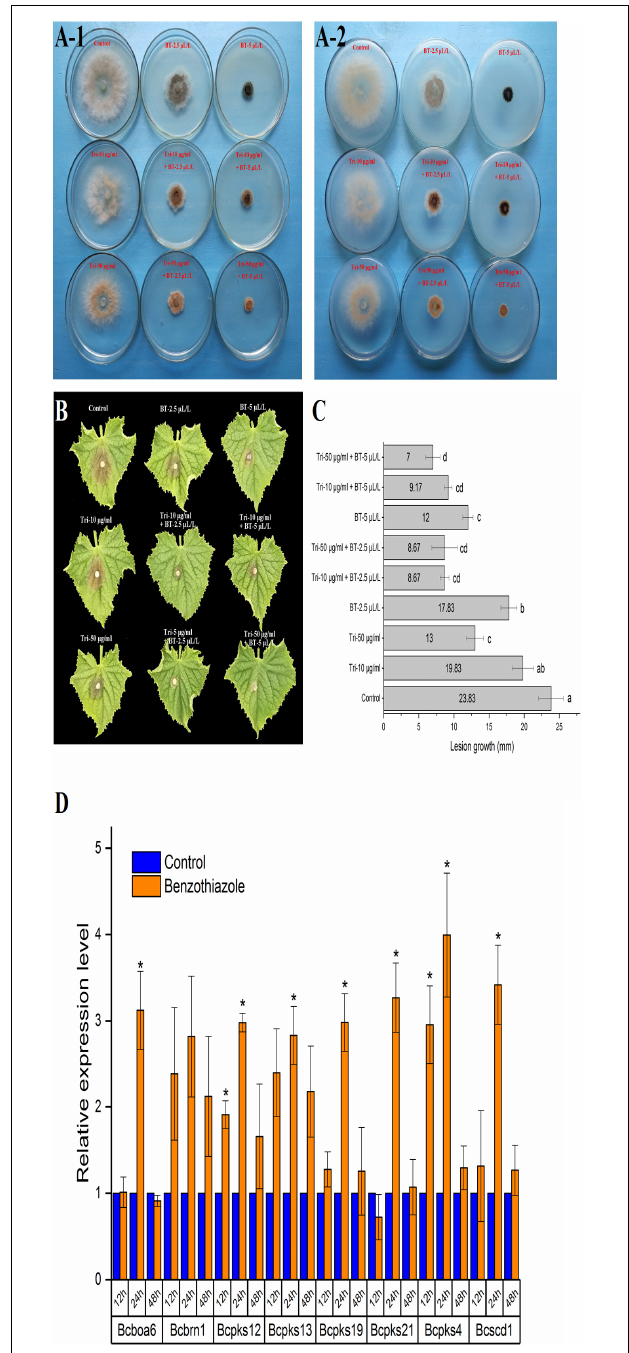
FIGURE 6 | Analysis of the effect of benzothiazole on melanin production in Botrytis cinerea . (A) Melanin biosynthesis of Botrytis cinerea with or without exposure to benzothiazole and tricyclazole (a fungal dihydroxynaphthalene melanin biosynthesis inhibitor) observed from the front (A-1) and back (A-2) of the petri dishes. (B) Virulence variation resulting from different extents of melanin biosynthesis inhibition. (C) Lesion growth diameters on the cucumber leaves from panel (B) . (D) Relative expression levels of melanin biosynthesis-related genes in Botrytis cinerea after fumigation with benzothiazole. The asterisk indicates a significant difference from the respective